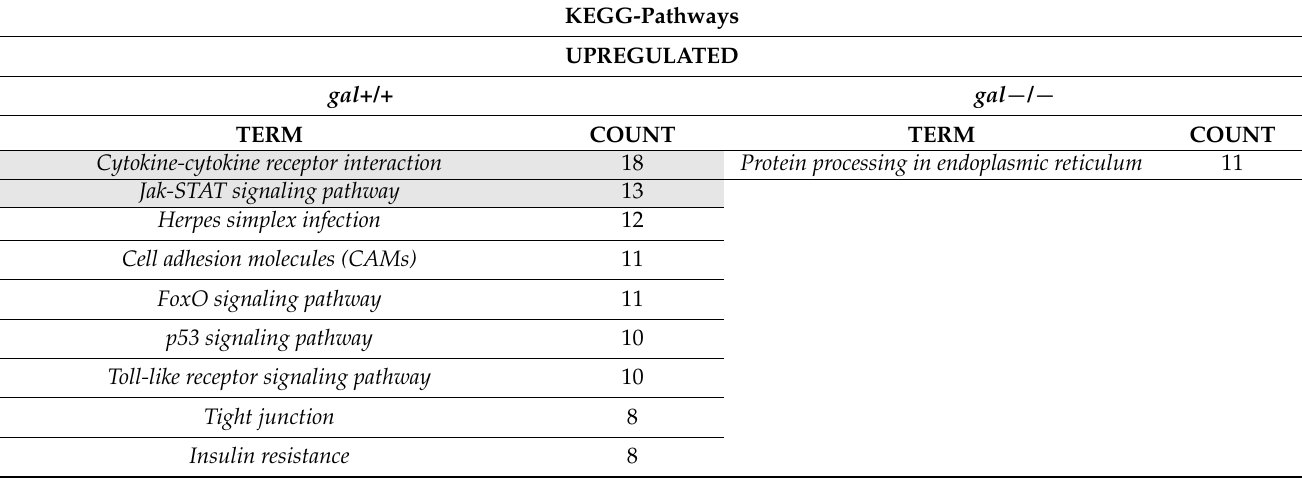
Table 1. Comparisons of affected pathways and biological processes in gal+/+ wild-type and gal − / − mutant larvae after M. marinum infection. Common processes are marked as